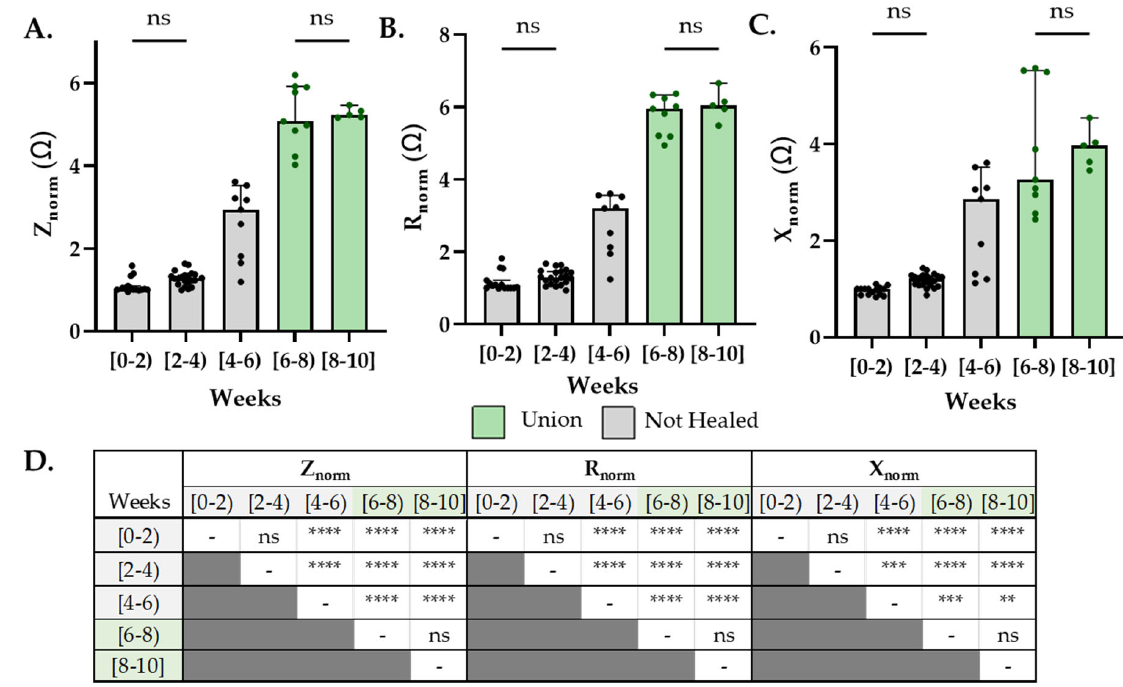
Figure 7. Sensors distinguish between union and not-healed fractures at all healing timepoints. ( A – C ) Sensor measurements grouped by healing timeframe (grey = not healed; green = union). ( D ) Only ns (no significance) shown on graph, all other comparisons are significant ( α = 0.05). Internal references are greyed out on graph, green highlight indicates healed fractures. Data analyzed by one-way ANOVA followed by Tukey post-hoc testing. ** = P < 0.01, *** = P < 0.005, **** = P < 0.001.